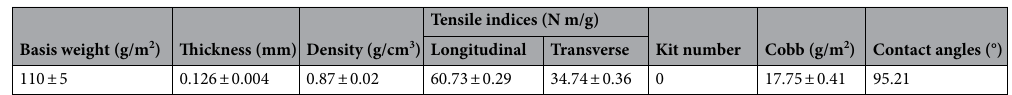
Table 2. Physical properties of base